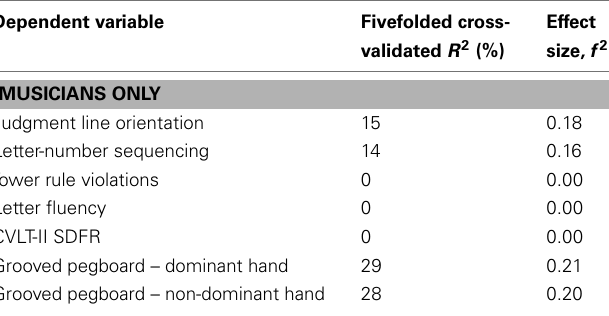
Table 3 | Effect sizes of all partition